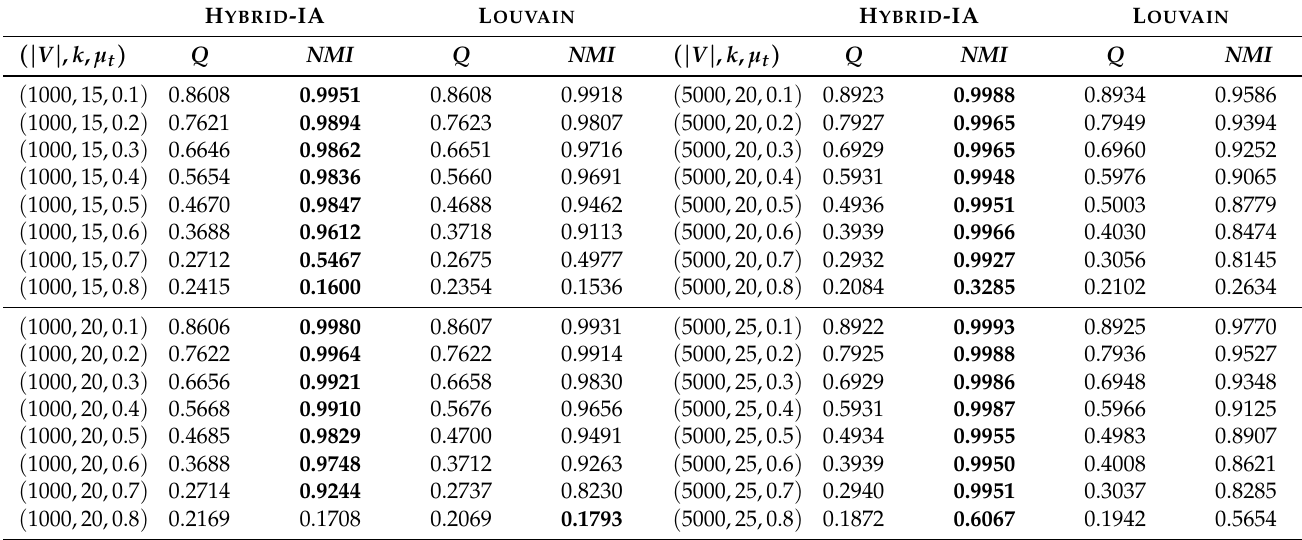
Table 3. Comparing H YBRID -IA and L OUVAIN on synthetic networks with 1000 and 5000 vertices, with respect to modularity ( Q ) and NMI evaluation metrics. In boldface are reported the best obtained values.